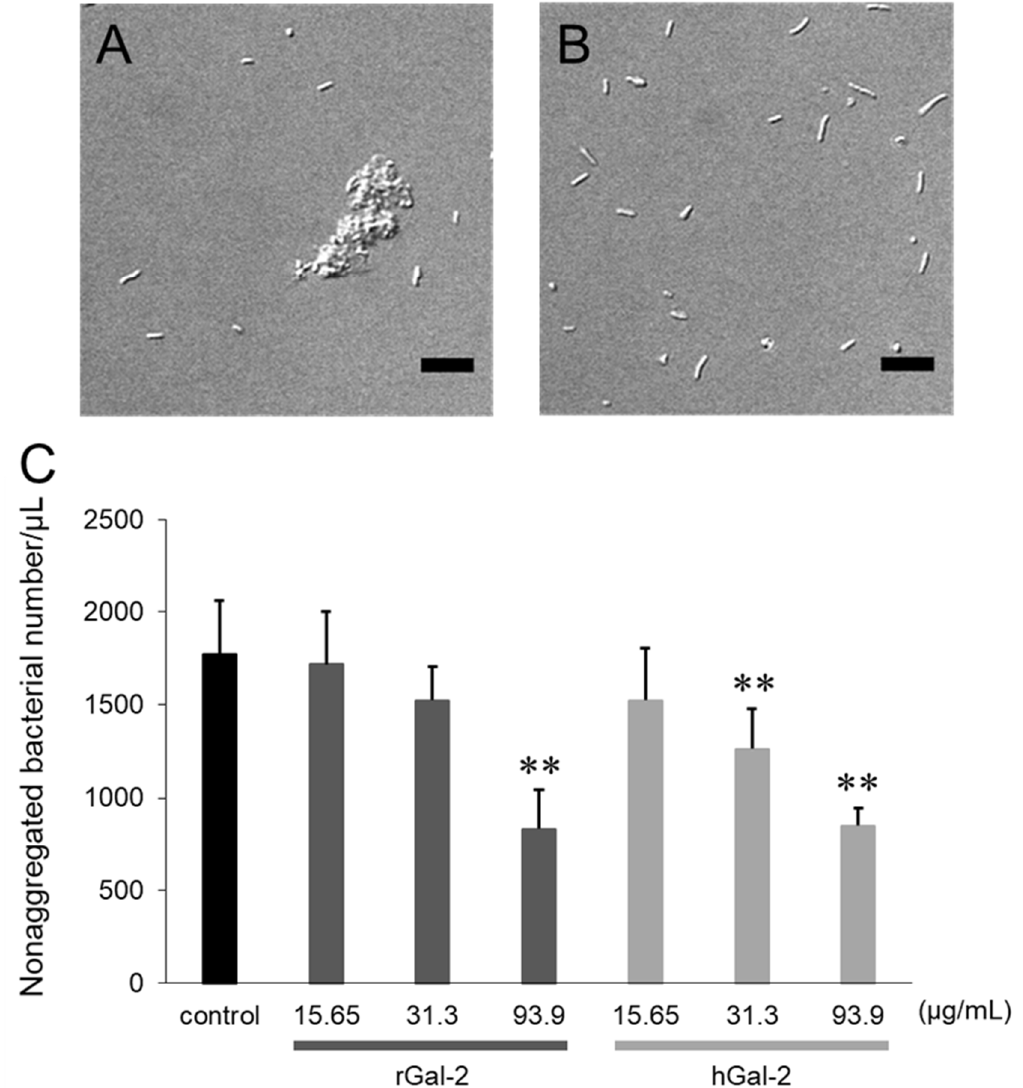
Figure 1. Aggregation of Helicobacter pylori -induced by Gal-2. ( A ) H. pylori suspension was observed under an optical microscope 1-h after mixing with the rat Gal-2 (rGal-2) solution. ( B ) The bacterial suspension after mixing with phosphate-buffered saline. ( C ) Relationship between bacterial aggregation and concentration of Gal-2. The black, dark gray, and light gray bars represent the control (without Gal-2), rGal-2, and hGal-2, respectively. Scale bar represents 10 µm. Each bar represents the mean ± standard deviation (SD) from five image samples. **, p < 0.01 by Dunnet’s test (vs. control).